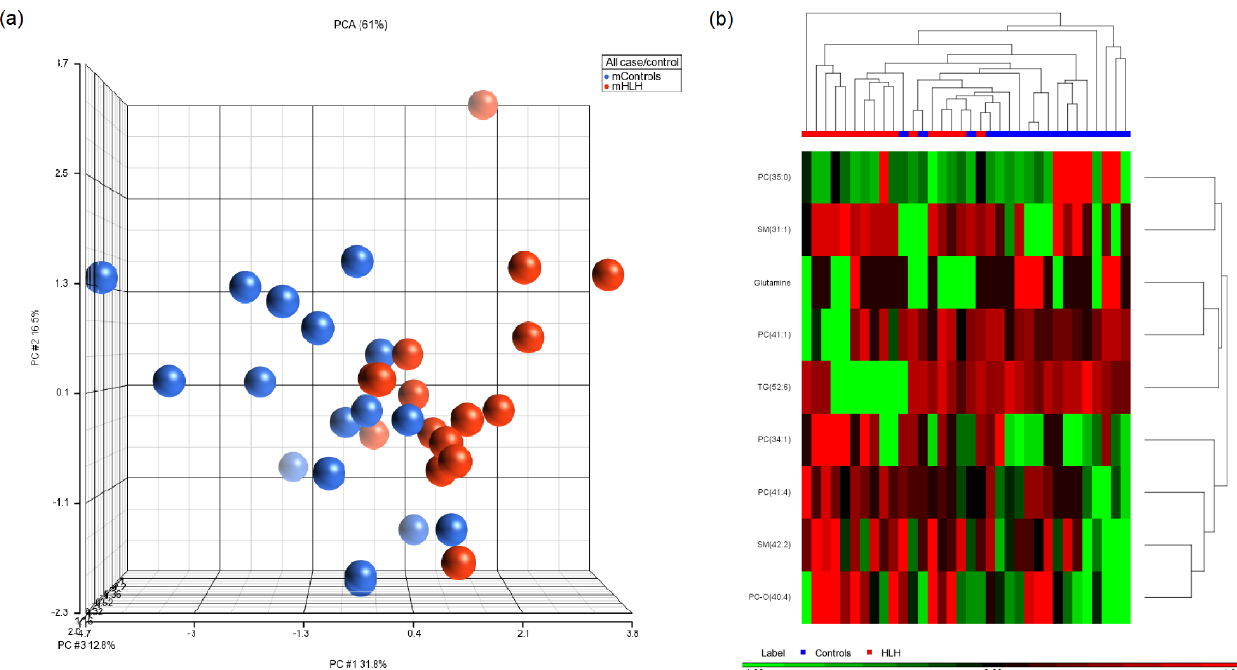
Figure 2. Visualization of the significant metabolites ( p < 0.05) in ( a ) principle component analysis and ( b ) hierarchical clustering distinguishing between mControl vs. mHLHS.